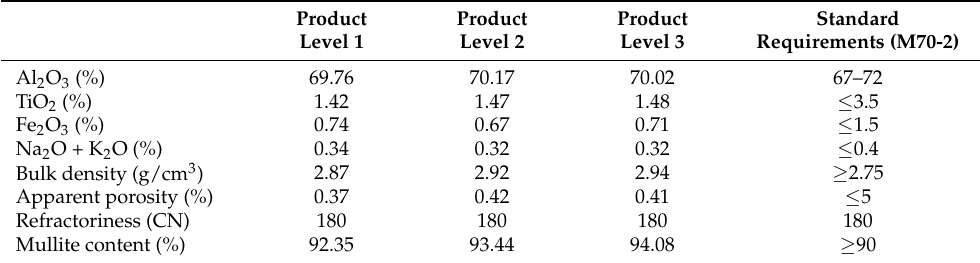
Figure 11. Morphology of mullite under different calcination times. Table 3. Comparison of properties between experimental product and standard